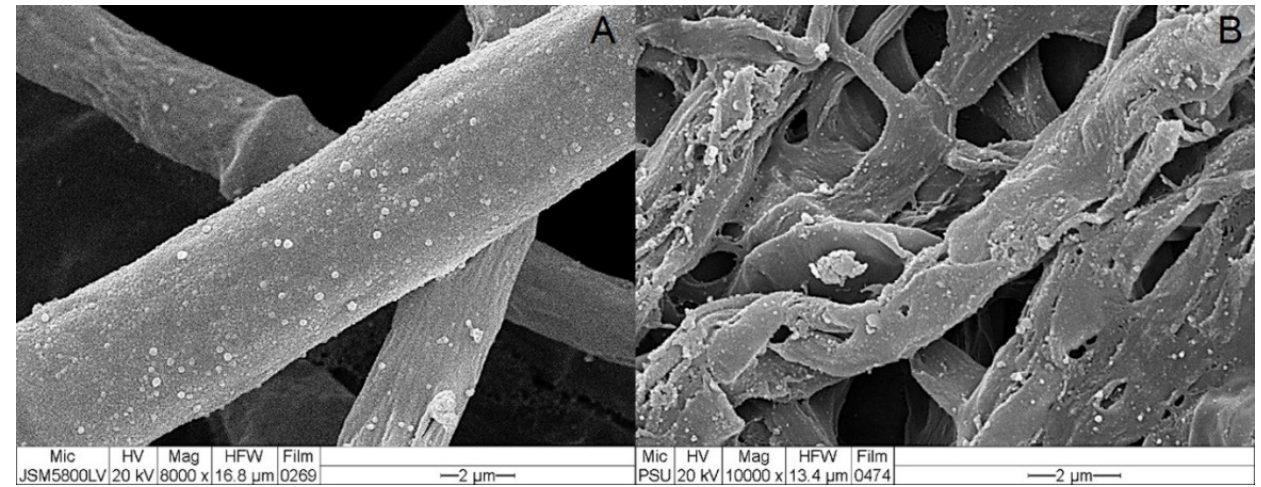
Figure 5. Effect of crude metabolite of Trichoderma asperelloides PSU-P1 treated muskmelon: ( A ) Stagonosporopsis cucurbitacearum hyphae treated with PDB (control), and ( B ) S. cucurbitacearum hyphae treated with a crude metabolite of T. asperelloides PSU-P1 observed by scanning electron microscope (SEM).